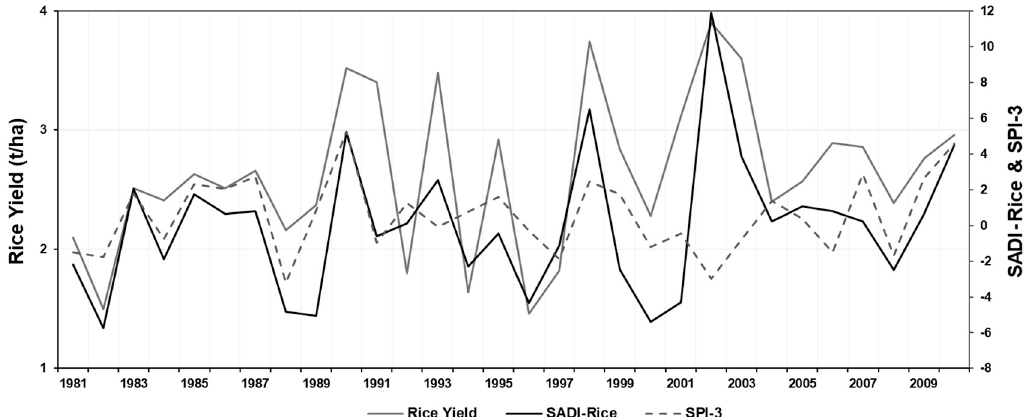
Figure 3. Annual comparison of the Standardized Agricultural Drought Index for rice (SADI-Rice), three-month Standardized Precipitation Index (SPI-3), and rainfed rice yield (1981–2010).